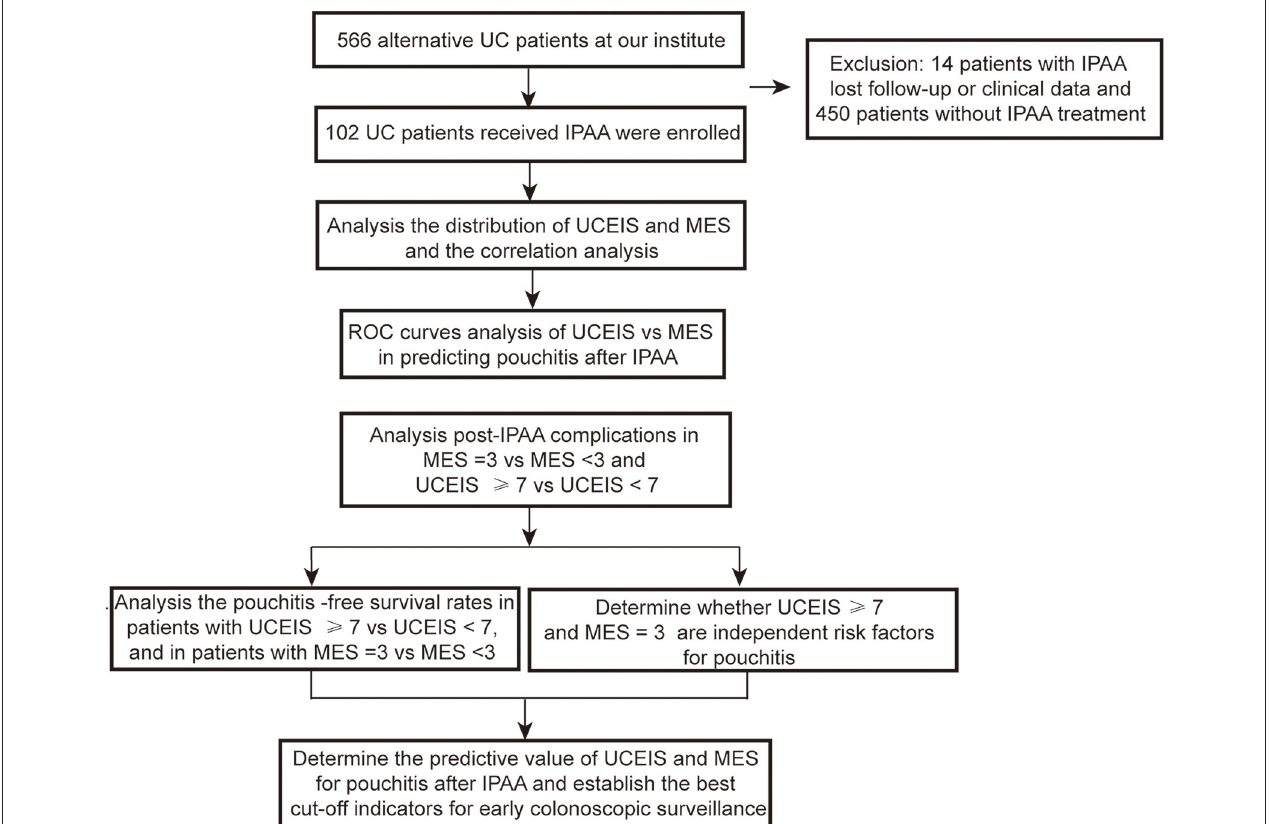
FIGURE 1 | A schematic flow diagram of this